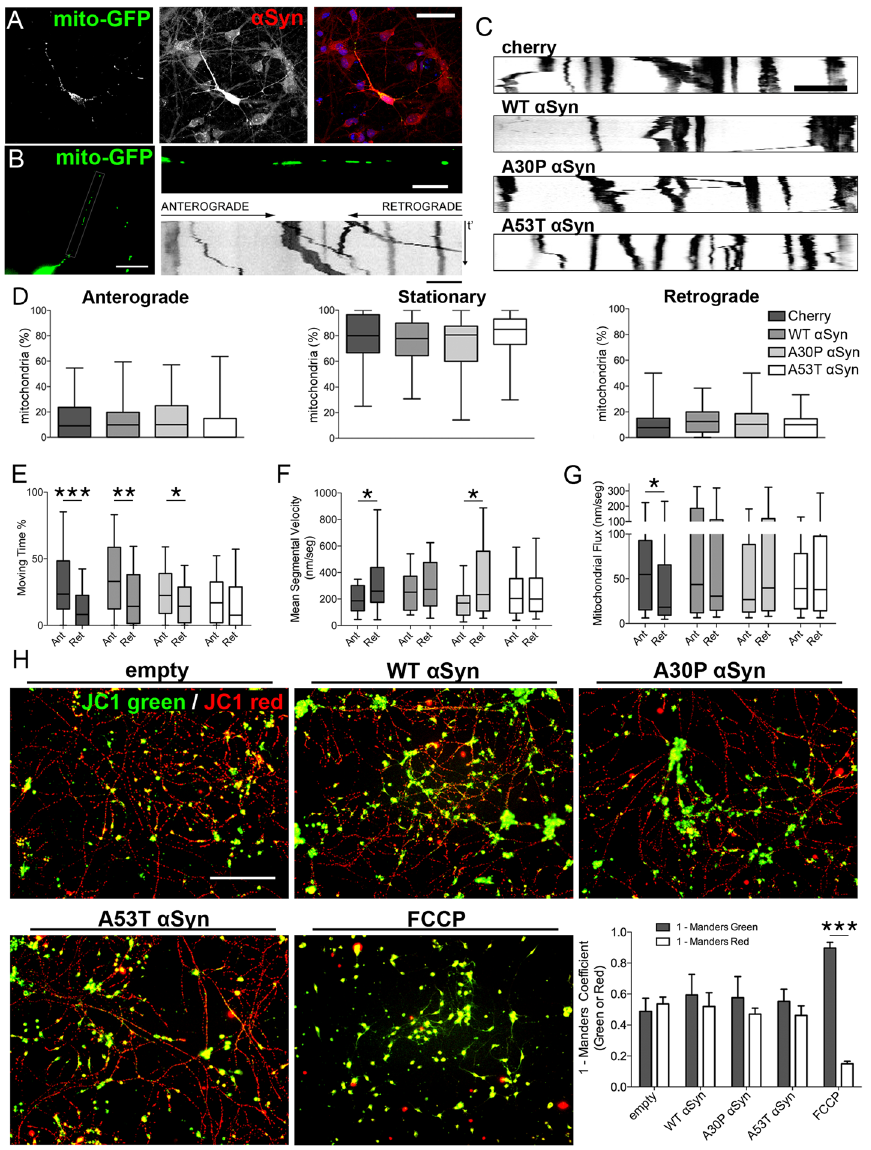
Figure 2. Mitochondrial axonal transport is differentially affected by α Syn variants. ( A ) Neuron co-transfected with mito-GFP and WT α Syn. Scale bar, 100 μ m. ( B ) Mitochondria (mito-GFP) in axonal projections from a transfected neuron used for live-imaging, magnified projection, and kymograph plotting. Kymograph obtained from a 150-s time-lapse movie at 3-s intervals. Left panel scale bar: 30 μ m, horizontal: 10 μ m. ( C ) Representative kymographs for α Syn transfected neurons obtained from supplementary movies (Sup Movies 1–4). Scale bar, 10 μ m. ( D ) Overall anterograde, retrograde, or stationary axonal mitochondrial proportion does not change upon α Syn overexpression. Data represented as median plus interquartile range (n > 50 axons per condition from 10 independent experiments). Kruskal-Wallis ANOVA for each type of movement (p > 0.05). ( E ) Anterograde to retrograde moving time differences observed in control mitochondria are lost in A53T transfected neurons but not in WT and A30P α Syn. ( F ) Anterograde to retrograde mean segmental velocity differences are lost in WT and A53T α Syn-transfected neurons (n = 60 per condition from 10 independent experiments). ( G ) Anterograde to retrograde mitochondrial flux (traveled distance per mitochondria normalized to acquisition time (nm/seg)) is impaired in all α Syn overexpression conditions compared with control (n = 60 per condition from 10 independent experiments). Data represented as median plus interquartile range. Mann-Whitney U test between anterograde and retrograde movements for each parameter. *** p < 0.001, ** p < 0.01, * p < 0.05. ( H ) α Syn overexpression does not impair mitochondrial membrane potential. Mitochondrial membrane potential was analyzed in transduced DIV14 neurons using JC1. Low and high (green and red emission, respectively) membrane potential was quantified by fluorescence intensity and Manders’ colocalization coefficient was calculated. Mitochondrial ionophore FCCP was used as positive control. Data represented as mean ± SEM (n = 7 independent experiments). Two-way ANOVA followed by Sidak’s corrected comparison of Manders’ coefficient for each condition, *** p > 0.001. Scale bar, 200 μ m. See also Movies M1–M4, Figure